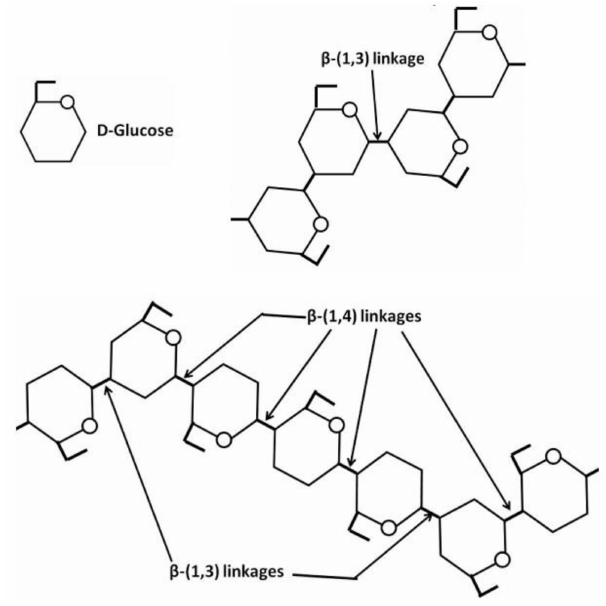
Figure 3. Schematic structure of fragments of β -(1,3)– and β